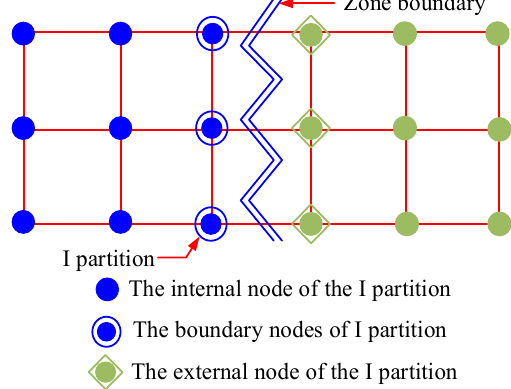
Figure 3. Example of the partitioning of a finite element grid.